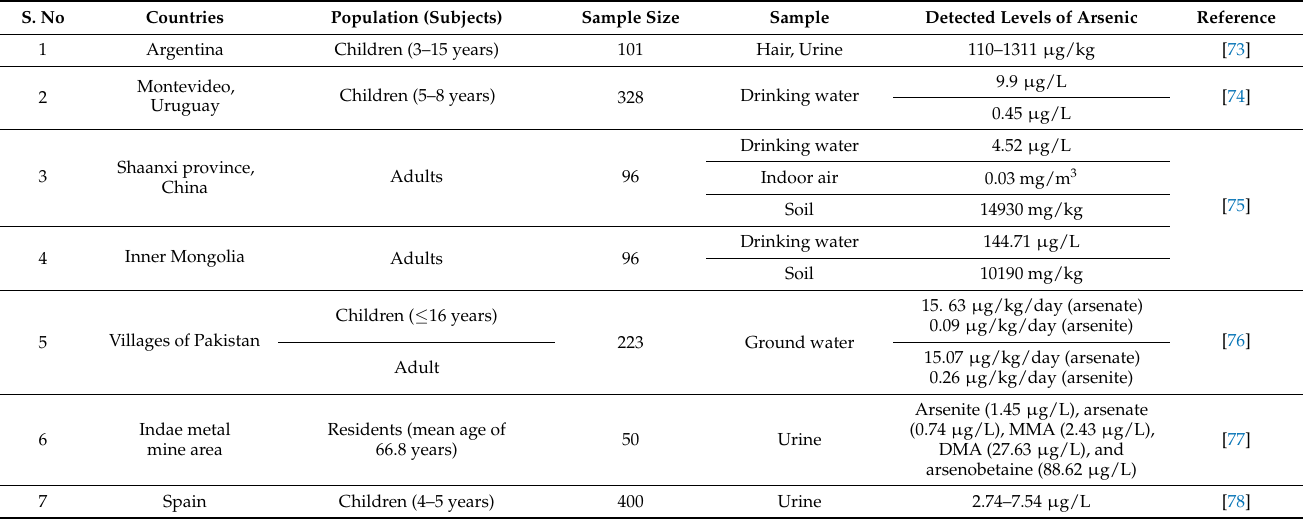
Table 1. Compilation of research studies showing the effect of arsenic exposures among diverse demographics in various parts of the world.